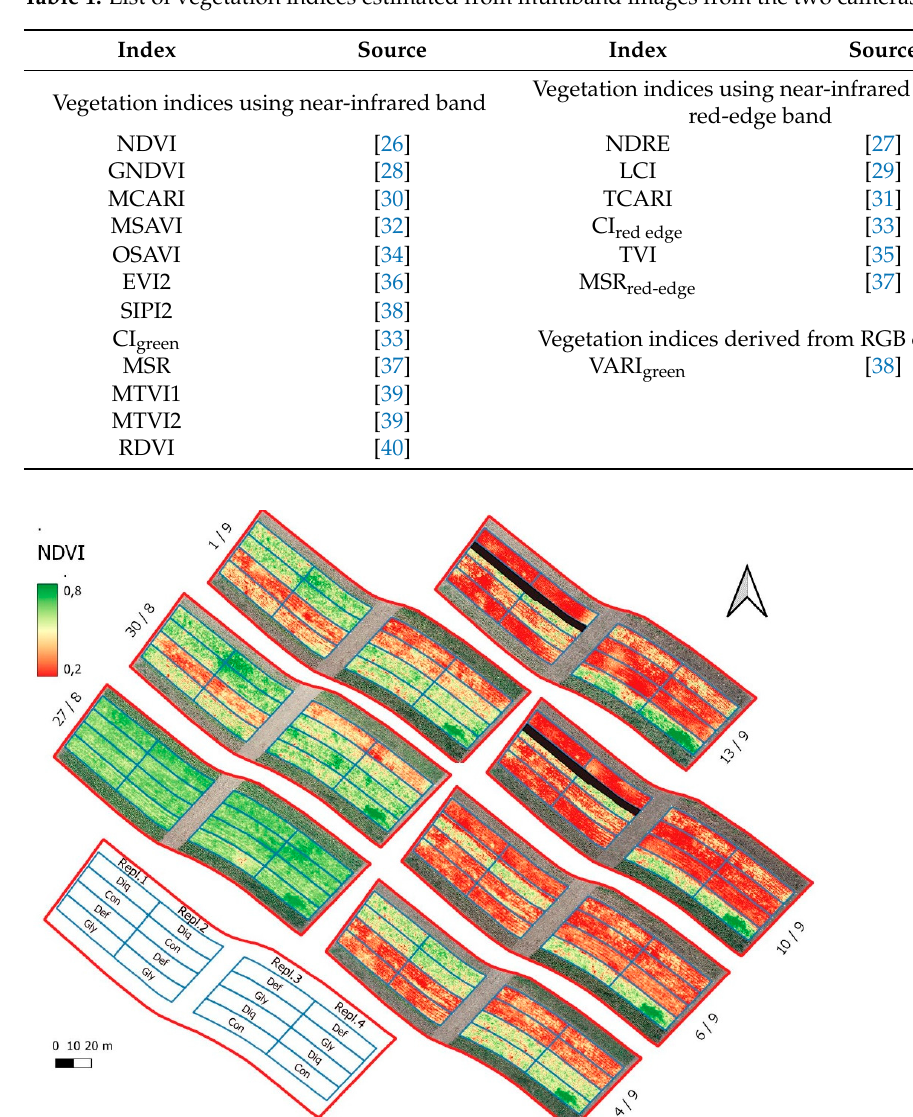
Figure 3. NDVI raster time series after spraying the harvest aid chemicals on 27 August 2021. The black area appearing in the CON treatment (replications 1 and 2) after 10/9 denotes a region used by the combine harvester for preliminary harvest tests and therefore was excluded from the analysis.